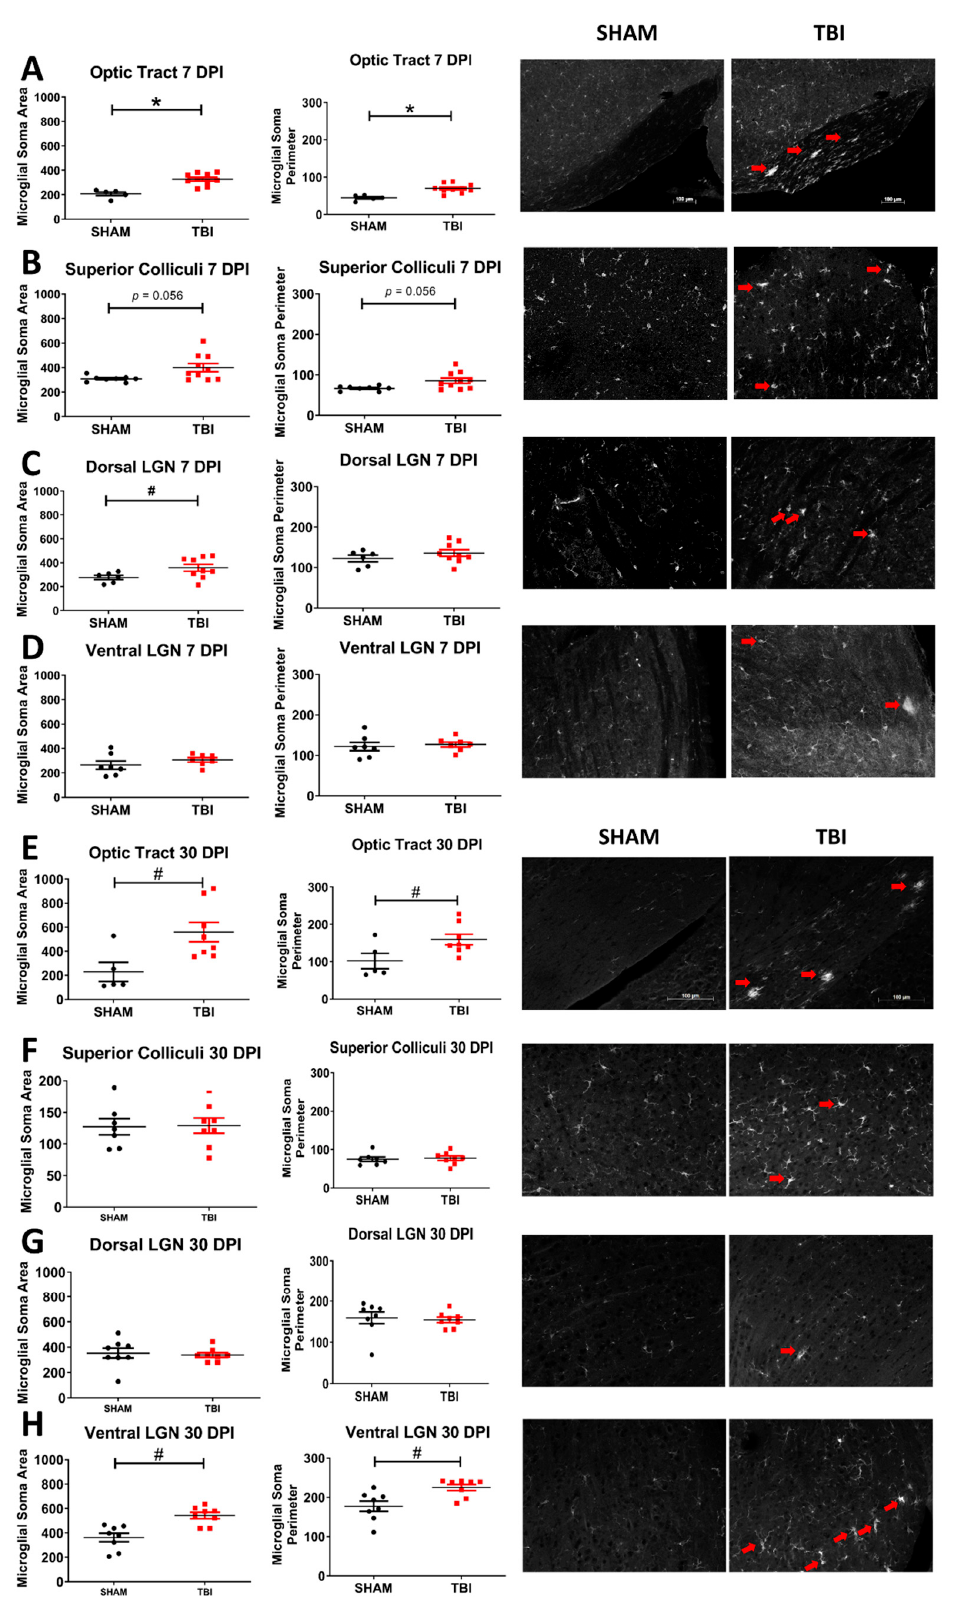
Figure 8. Morphologic evidence of microglial activation in the optic system is present 7 ( A – D ) and 30 ( E – H ) DPI. These morphologic changes are particularly predominant in the OT but can also clearly be seen in other regions (red arrows). Representative photomicrographs taken at 10 × magnification, scale bar 100 µ m. # p < 0.05. Higher magnification images can be found in Supplementary Figure S3, * p <